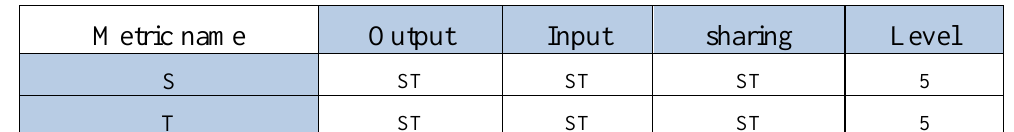
Table 8: level 5